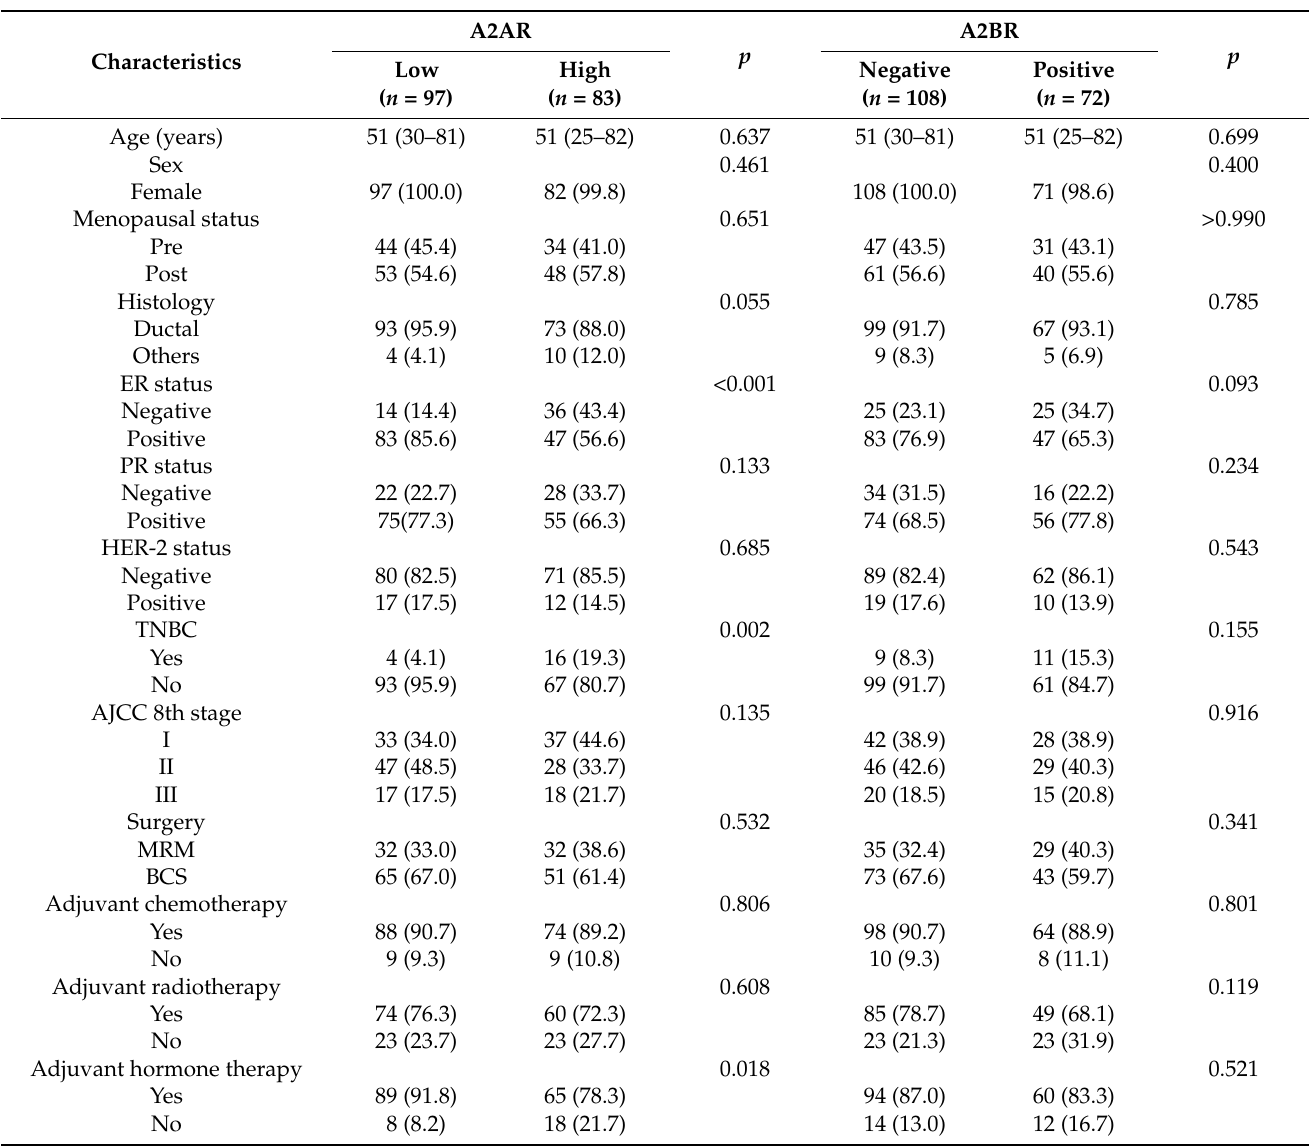
Table 1. Association between P1 receptors, A2AR and A2BR, and clinicopathological characteristics in breast cancer patients.